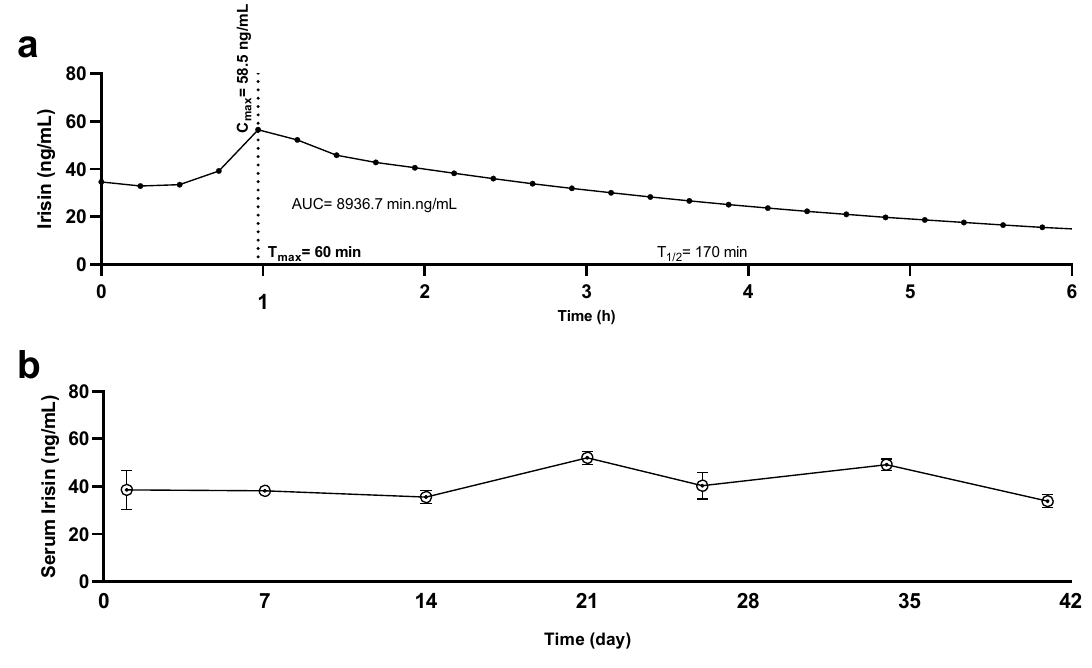
Figure 2. Pharmacokinetic profiles of irisin. Serum sampling and irisin quantification of Sprague Dawley rats administered irisin via ( a ) a subcutaneous route and ( b ) an osmotic pump. Dotted line represents time (T max ) it takes for irisin to reach the maximum concentration (C max ).